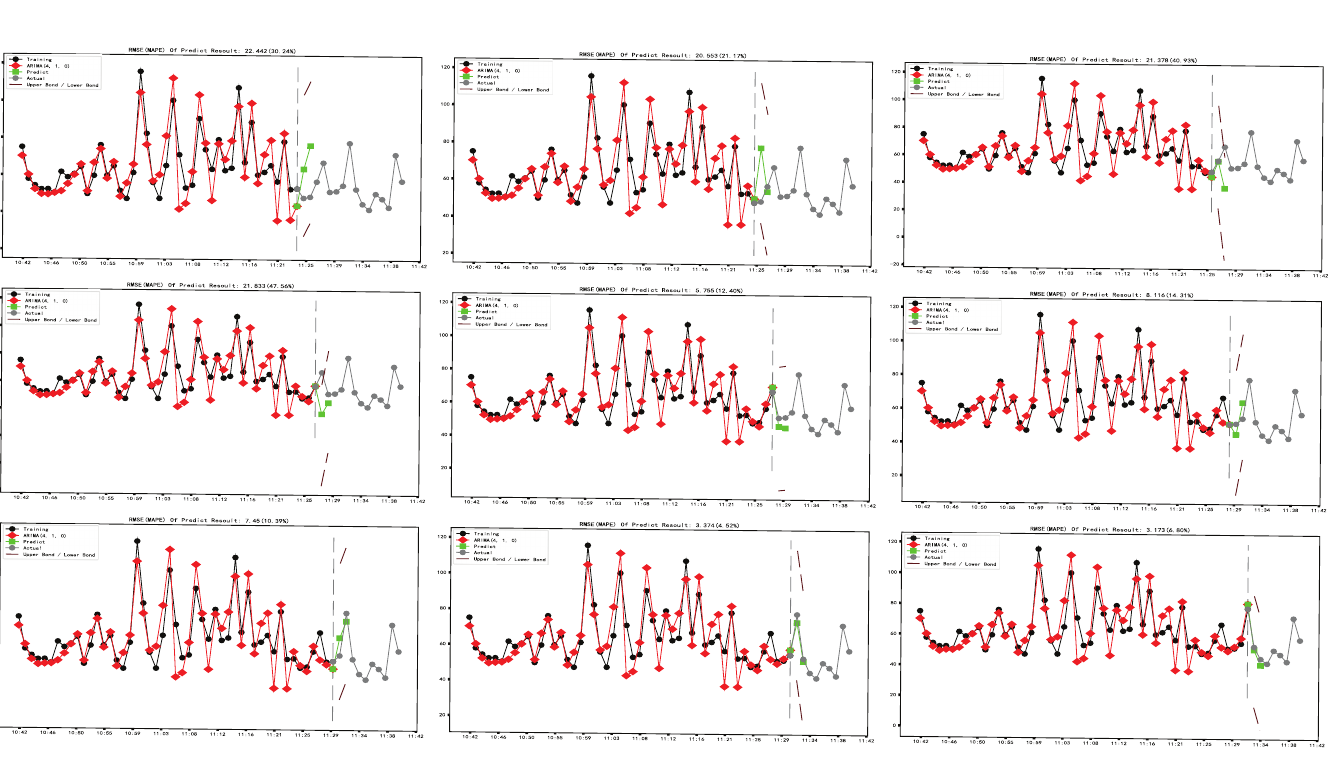
Fig 24. ARIMA (4,1,0) model cross-validation.